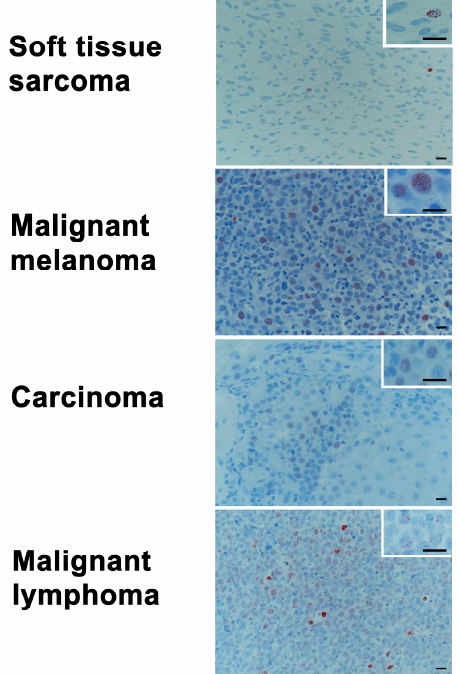
Figure 4. Examples of baseline levels γ H2AX immunohistochemical labeling in indicated tumor types. (Bars: overview 20 µ m, insert 15 µ m); (Immunoperoxidase, haematoxylin-conterstain: brown intranuclear dots represent γ H2AX-foci).